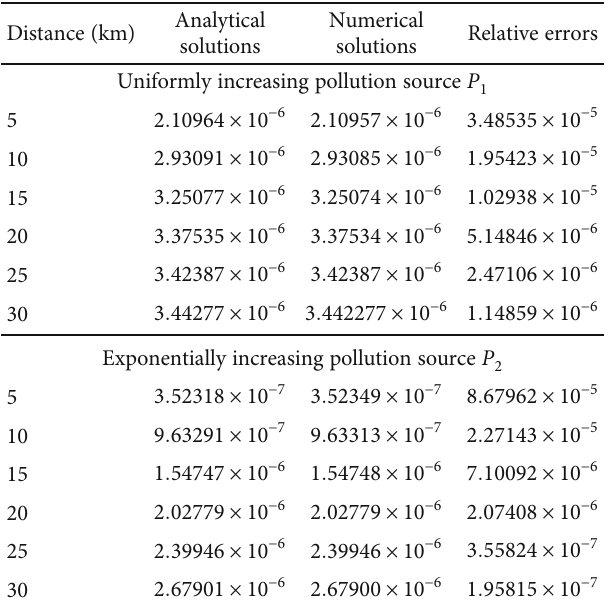
and P at t = 0 : 01 , 0.1, and 1 day. 1 2 Table 1: Relative error of pollutant concentrations by Δ x = 0 : 1 and Δ t = 0 : 001 at t = 1